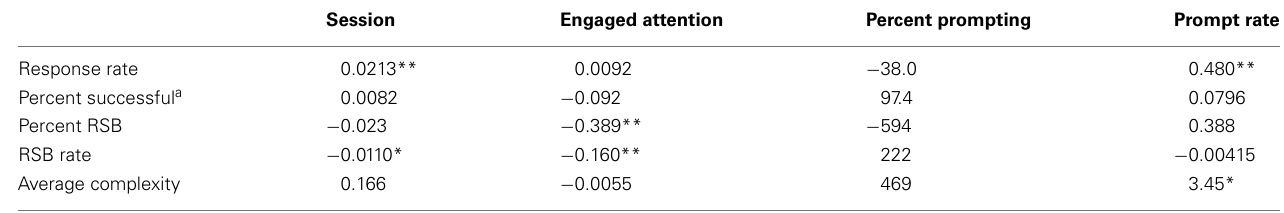
Table 6 | Regression coefficients for RSB and responses.